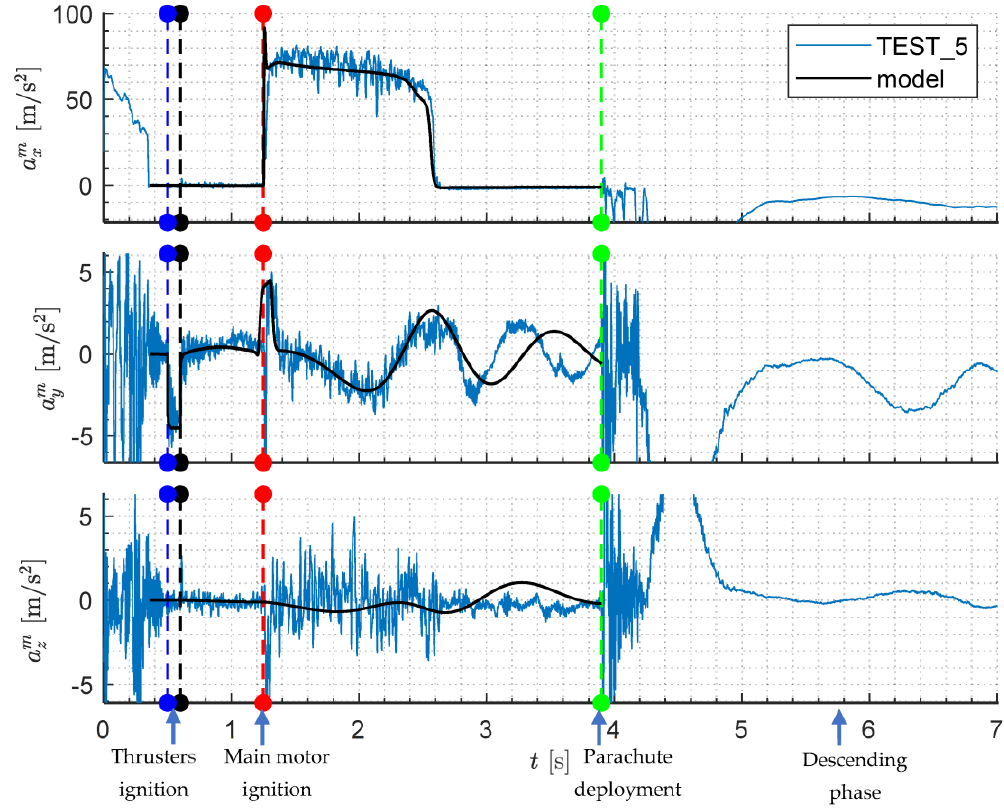
Figure 26. Accelerations (test 5, lateral thrusters behind the center of mass).